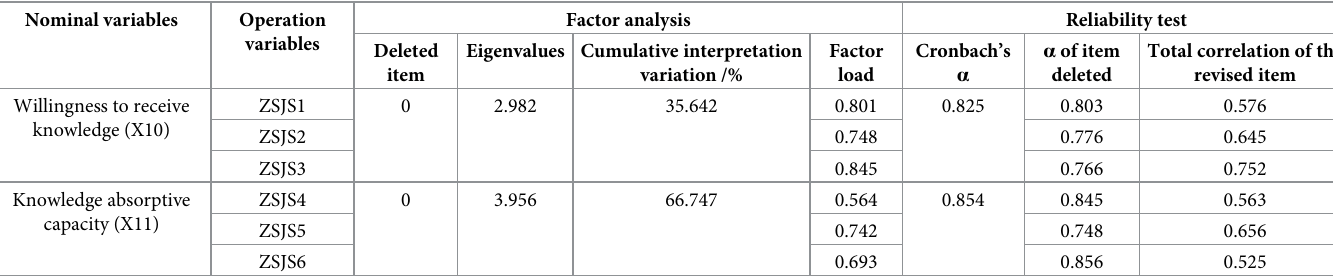
Table 10. Factor analysis and reliability test scale results regarding the knowledge